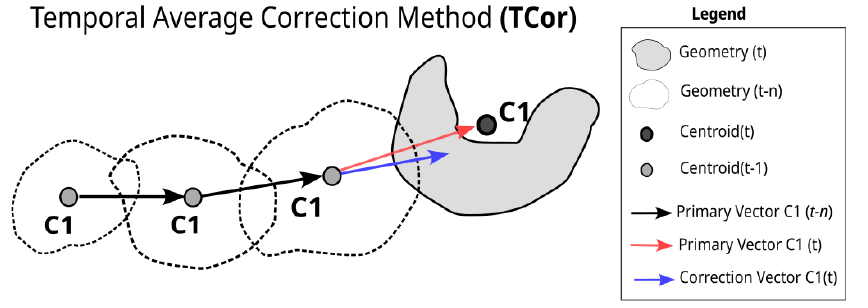
Figure 6. Schematic for temporal average vector correction method. The cells of observations before t are represented by unfilled polygons with their respective displacement vectors (black